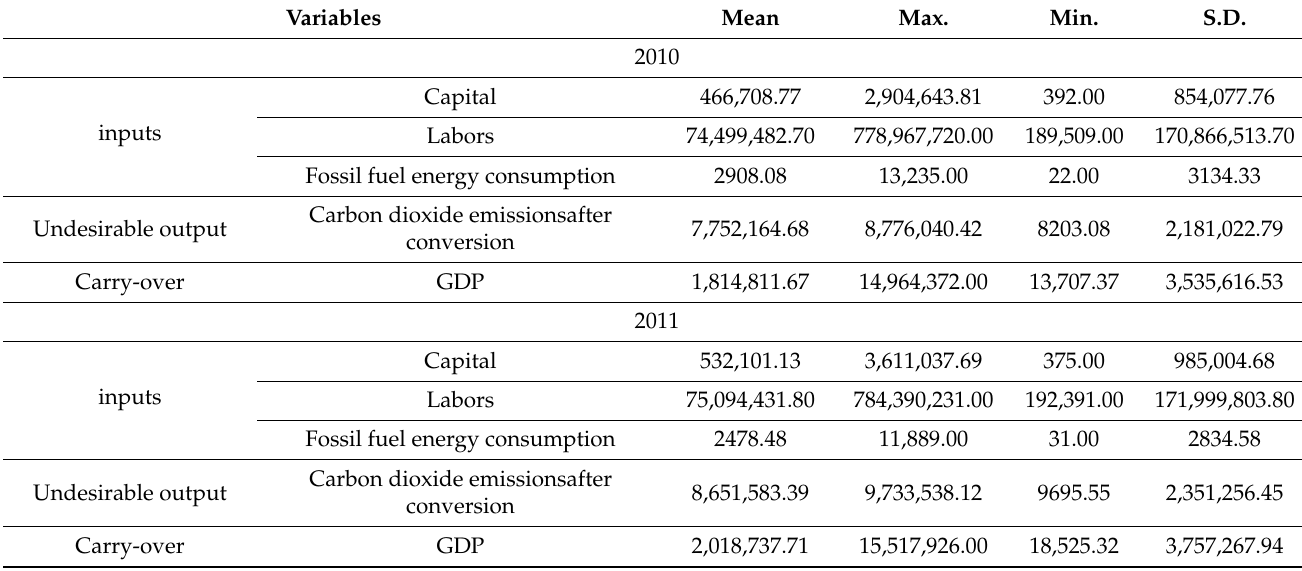
Table 5. Descriptive statistics for variables of APEC economies during